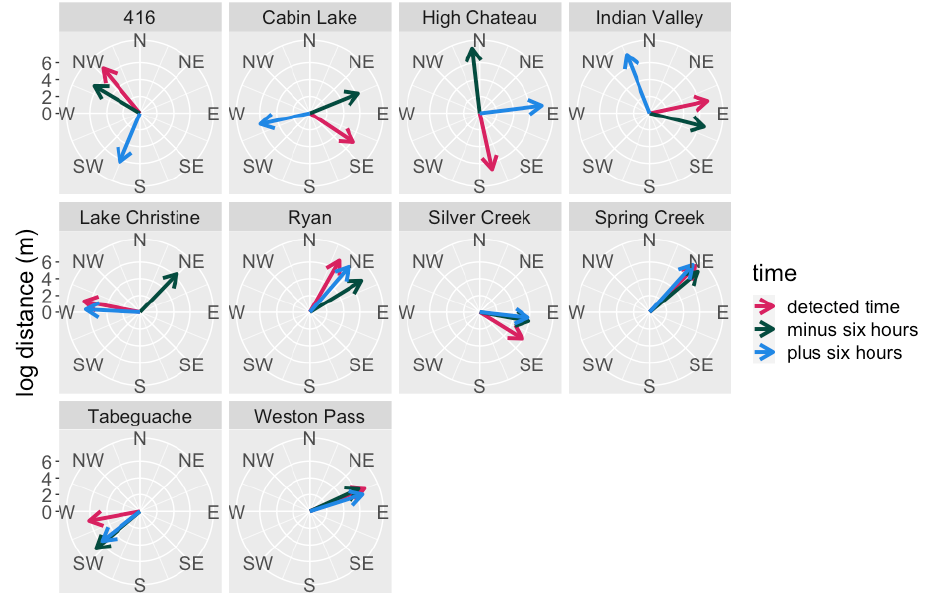
Figure 9. Forecast propagation direction for simulations initiated at the detection location at the time of detection (magenta), six hours before (dark green), and six hours after (blue).